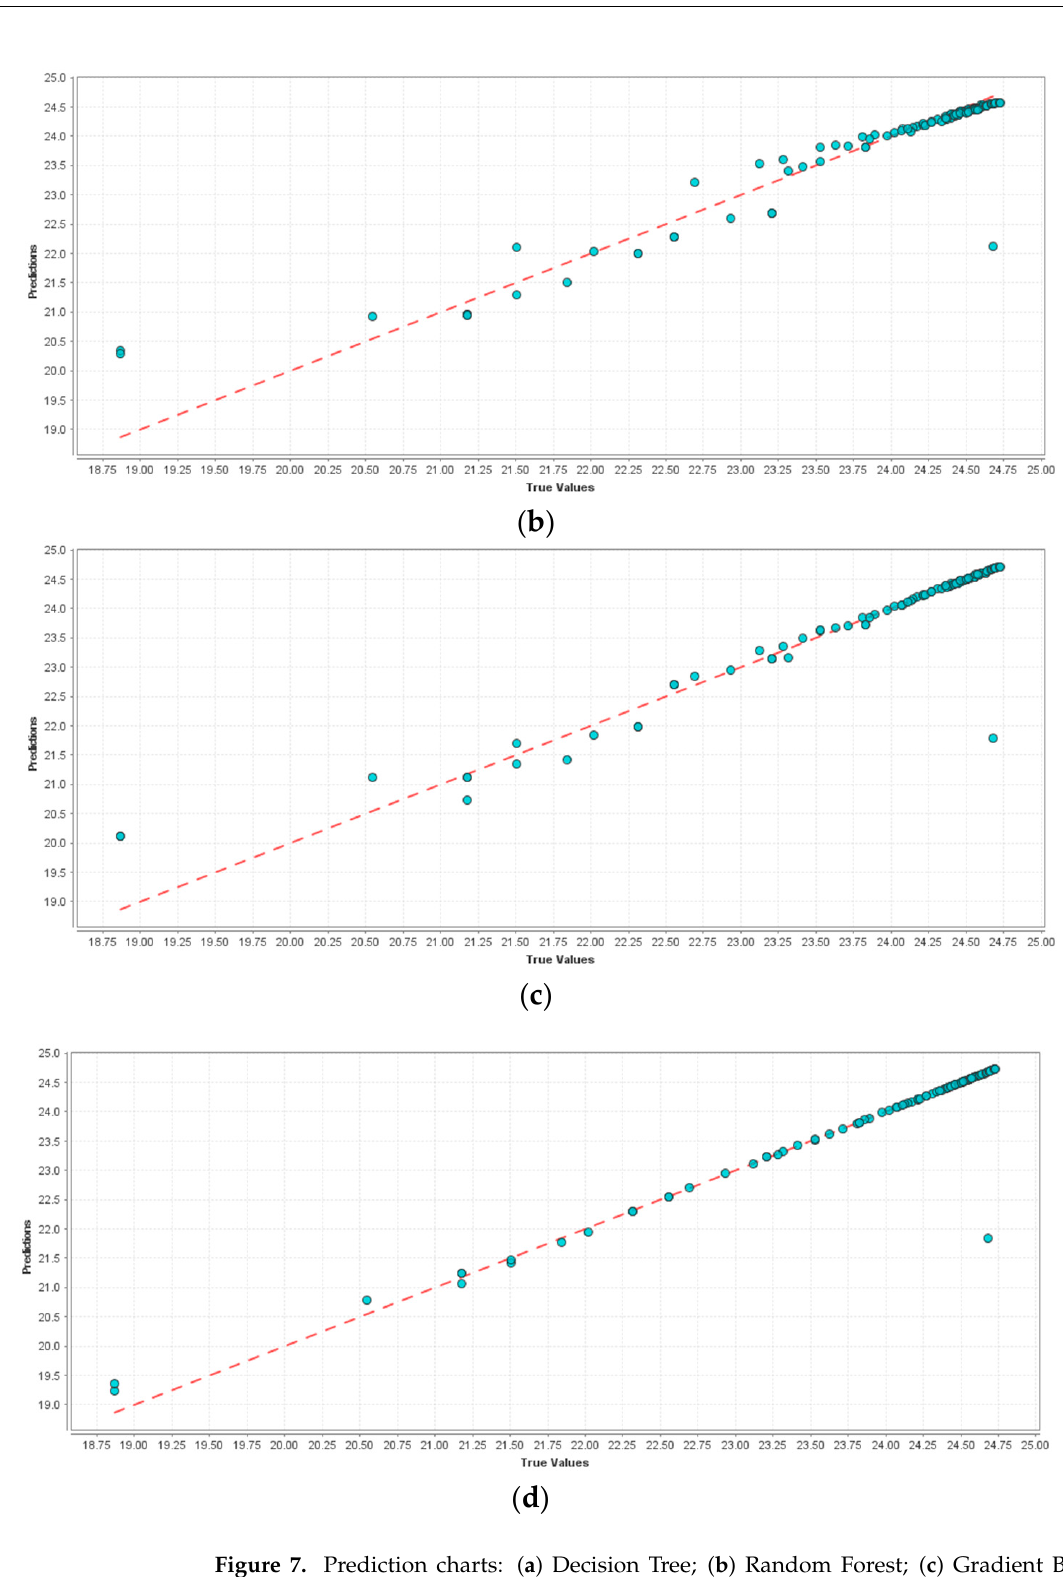
Figure 7. Prediction charts: ( a ) Decision Tree; ( b ) Random Forest; ( c ) Gradient Boosted Trees; ( d ) Support Vector Machine.